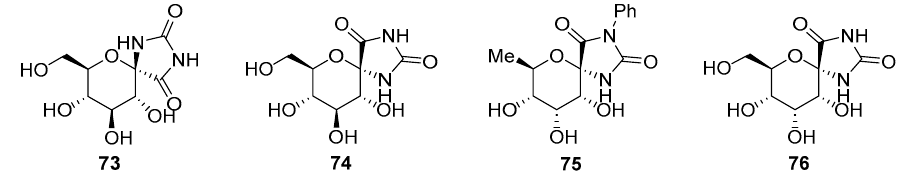
Figure 5. Pyranose derivatives of hydantocidin.